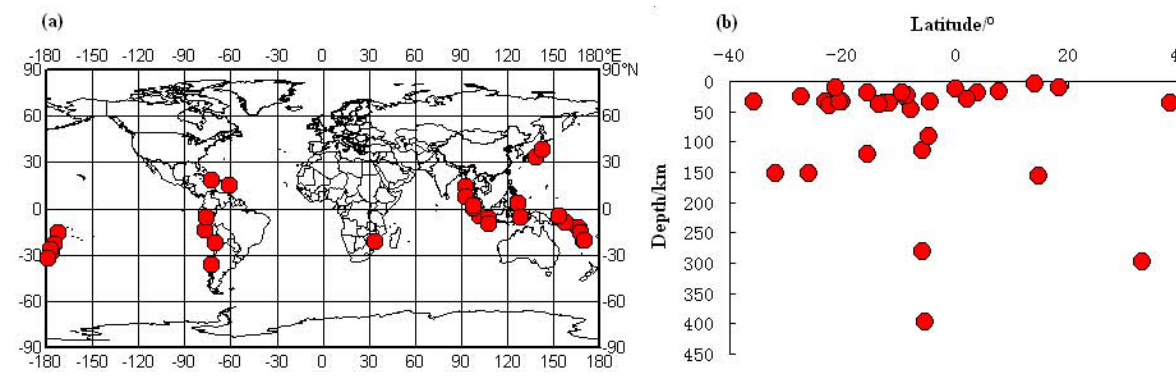
Fig. 3. Spatial (a) and depth (b) distribution of earthquakes with electrostatic perturbations (the circle represents the